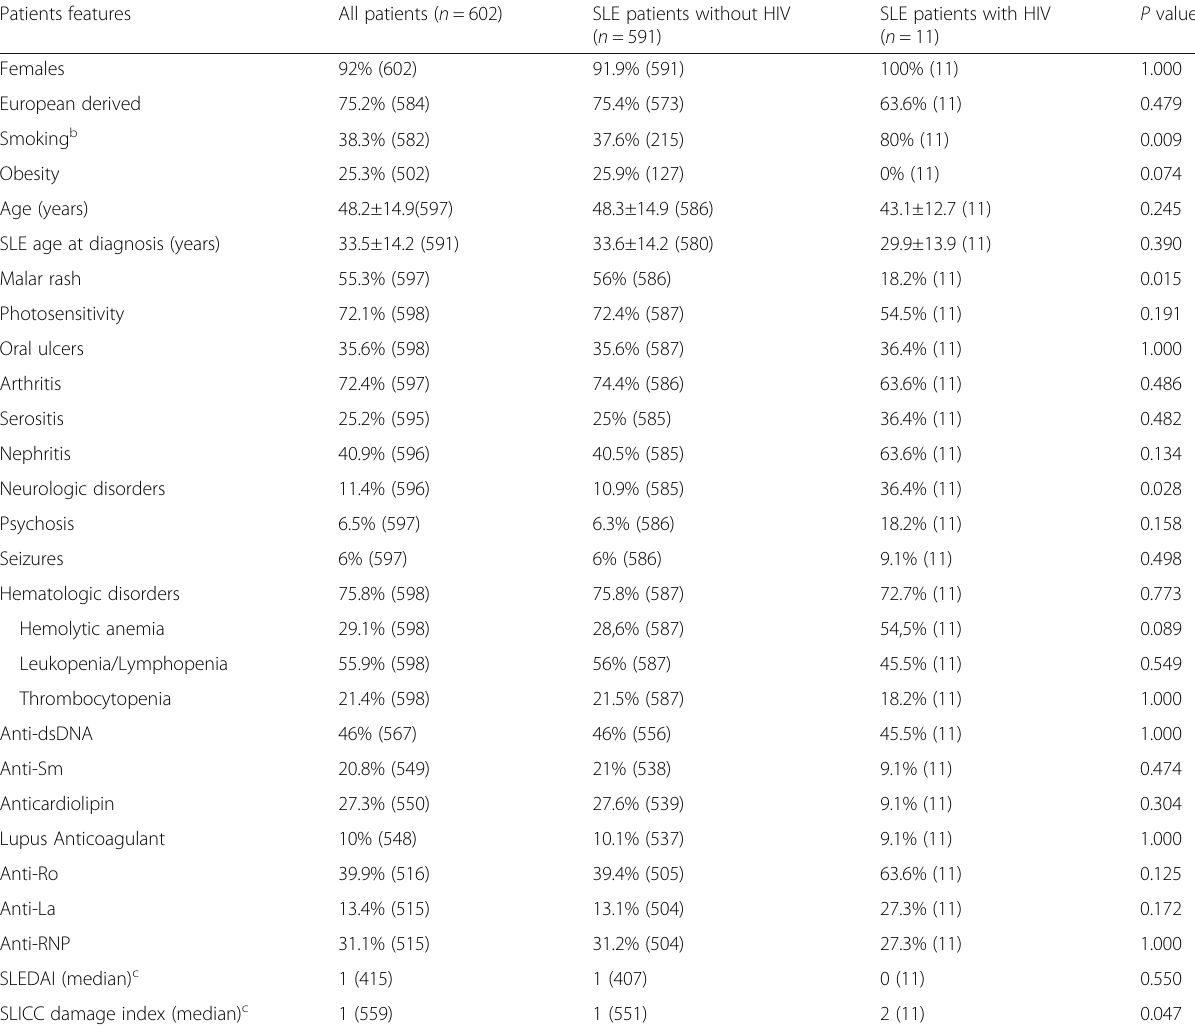
Table 1 Demographic, clinical, and laboratory features of SLE patients with and without HIV infection Patients features All patients ( n =